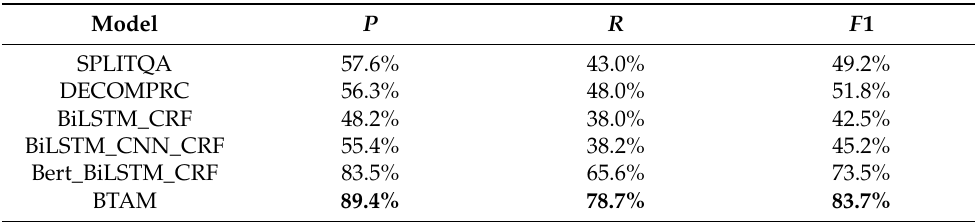
Table 4. Performance of different models on ComplexWebQuestions